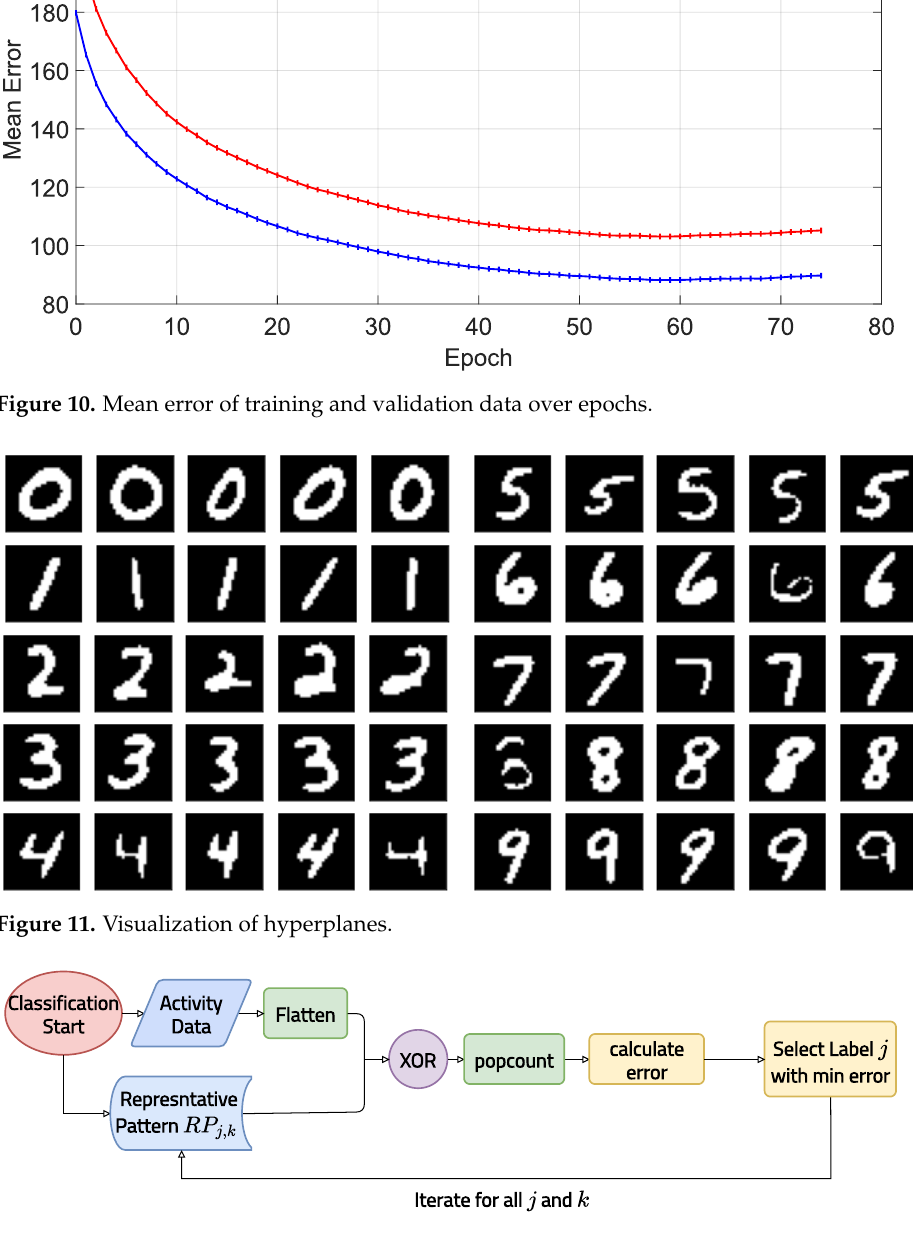
Figure 12. Overall algorithm of the classification